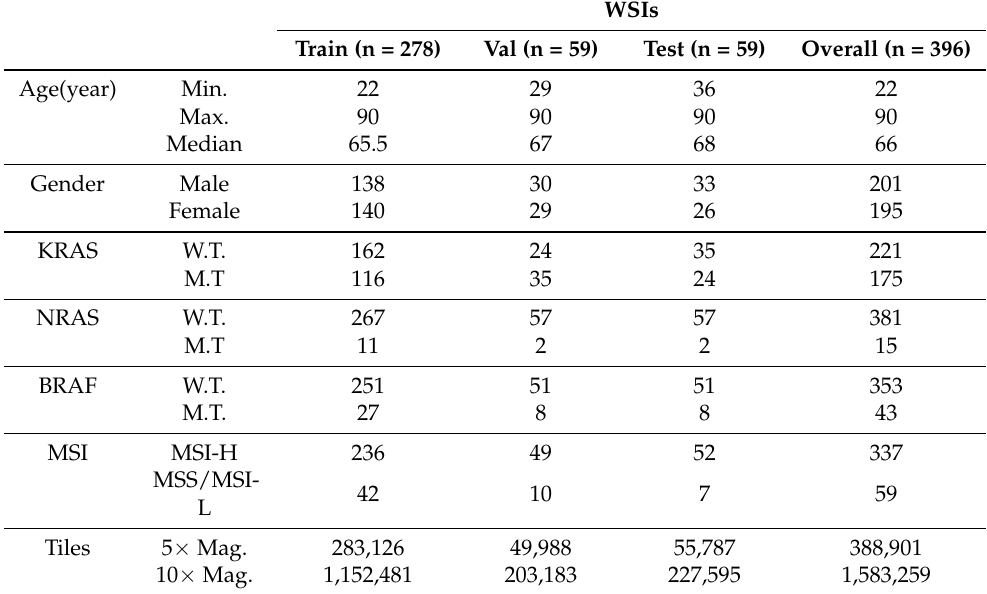
Table 1. Distribution of patients and whole-side images